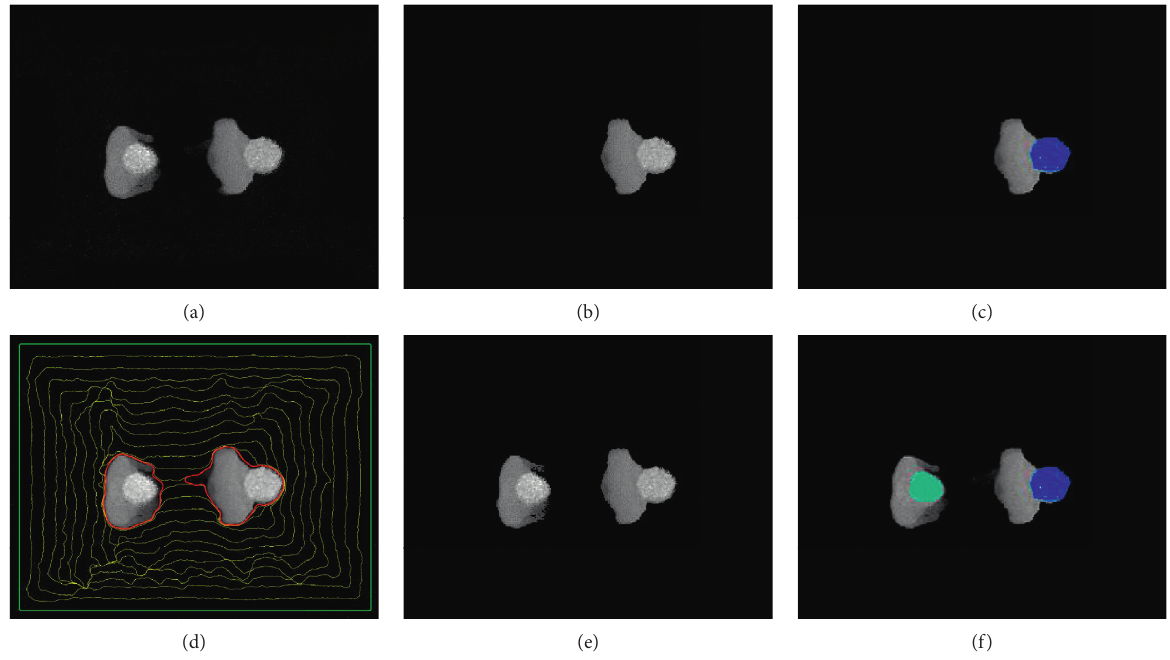
Figure 6: Experiments with two-pedestrian image. (a) Original image with two pedestrians. (b) Image obtained by the MCR algorithm along with the original image. (c) Image obtained by the MSER-based segmentation along with (b). (d, e) The processes and result images obtained by the RD-LSE along with the original image. (f) Image obtained by the MSER-based segmentation along with that in (e).